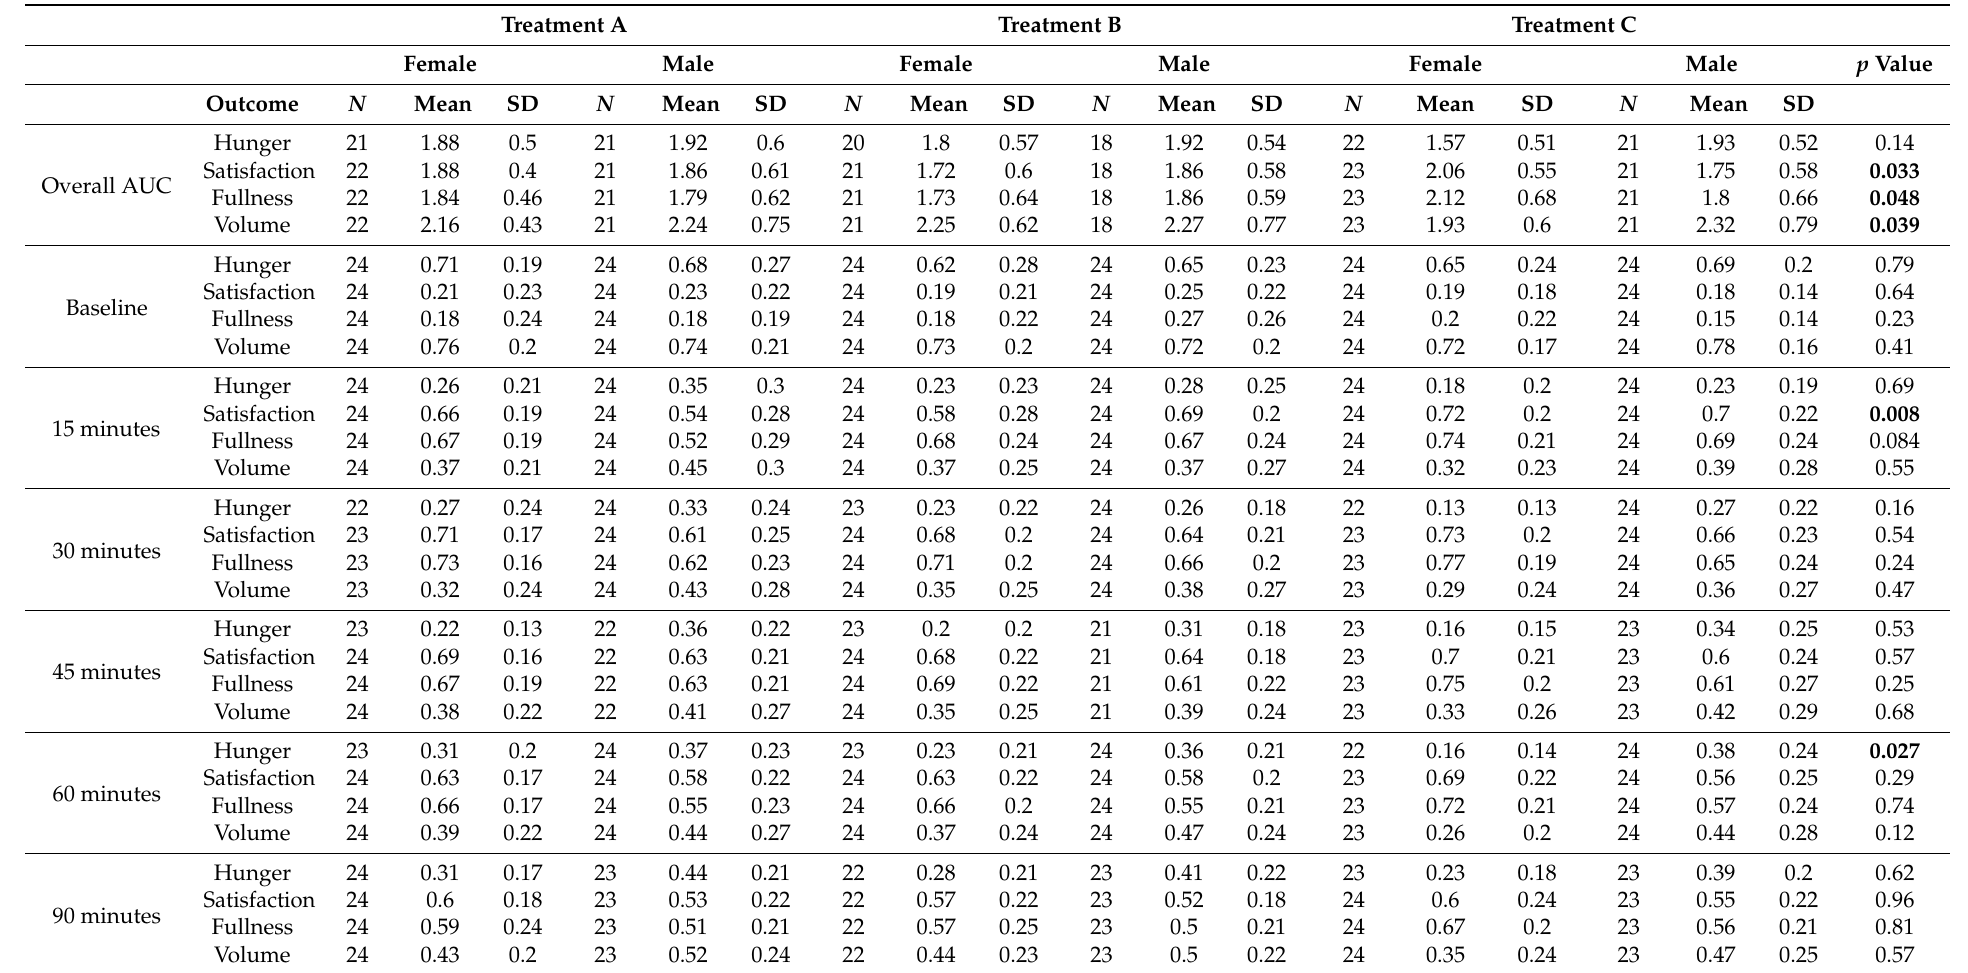
Table 4. Satiety results by